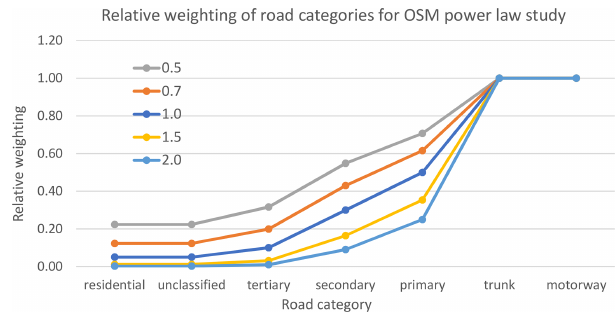
Figure 12. OSM weighting, relative to motorways, that results with a change in the power-law index when applied to the initial weights. The scenarios are tested in the European